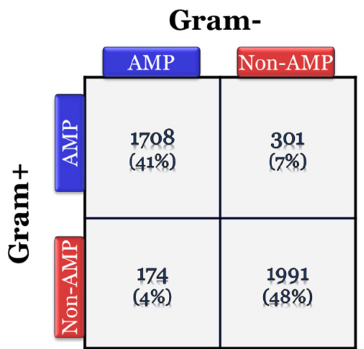
Figure 4. Matrix of labels for the common peptides between Gram − and Gram+